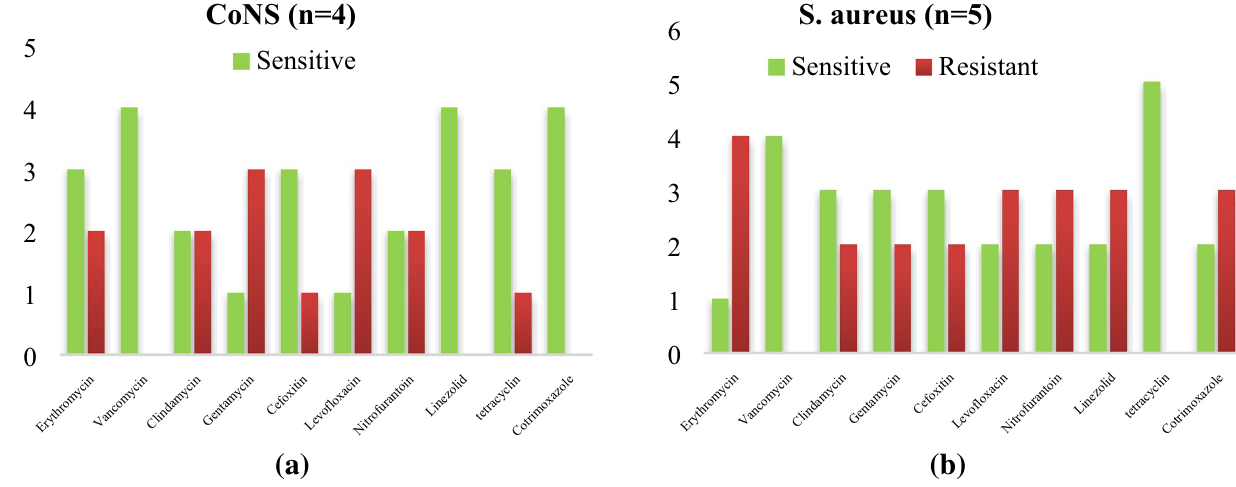
Figure 9. ( a ) Antibiogram of CoNS isolated from hands of health care workers of NICU. ( b ) Antibiogram of S.aureus isolated from hands of health care workers of NICU. Out of total CoNS isolated maximum sensitivity was shown for Linezolid (4/4) and Vancomycin (4/4) whereas for S aureus tetracycline (5/5) and Vancomycin (4/5) showing maximum sensitivity pattern.